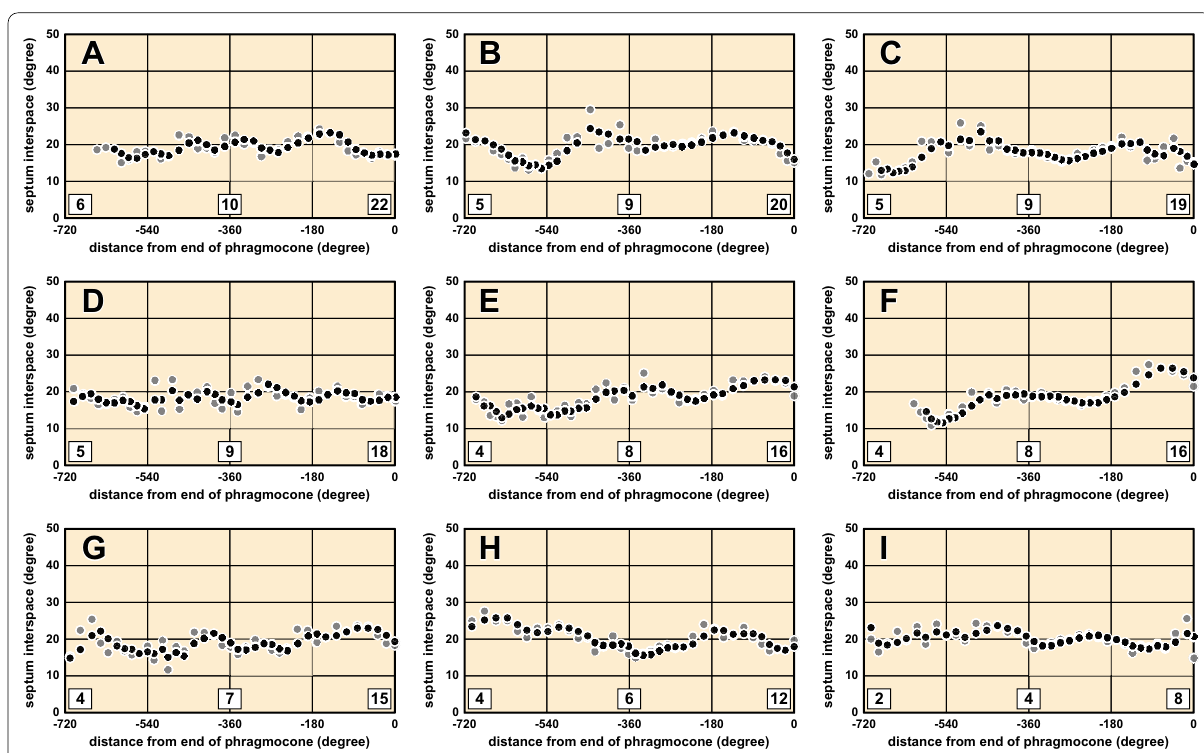
Fig. 15 Ontogenetic trajectories of septal distances in nine specimens of Pseudoprobeloceras nebechense (Bensaïd, 1974) from Hassi Nebech, specimens MB.C.30284.1-9. Respective phragmocone diameters (in mm) in the bottom boxes